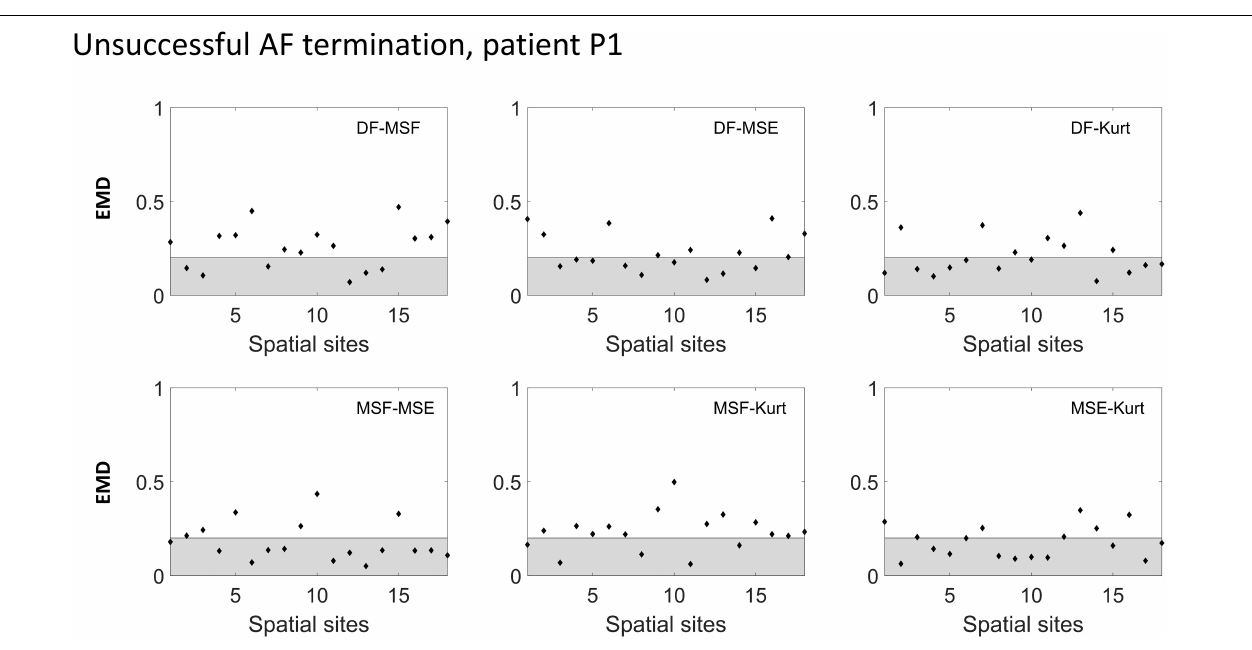
FIGURE 4 | Earth mover’s distance (EMD) values calculated for the different pairs of approaches (DF, MSF, MSE, and Kt) in an unsuccessful AF termination patient P1. The gray area indicates the region where the correlation between the pairs is high (EMD <